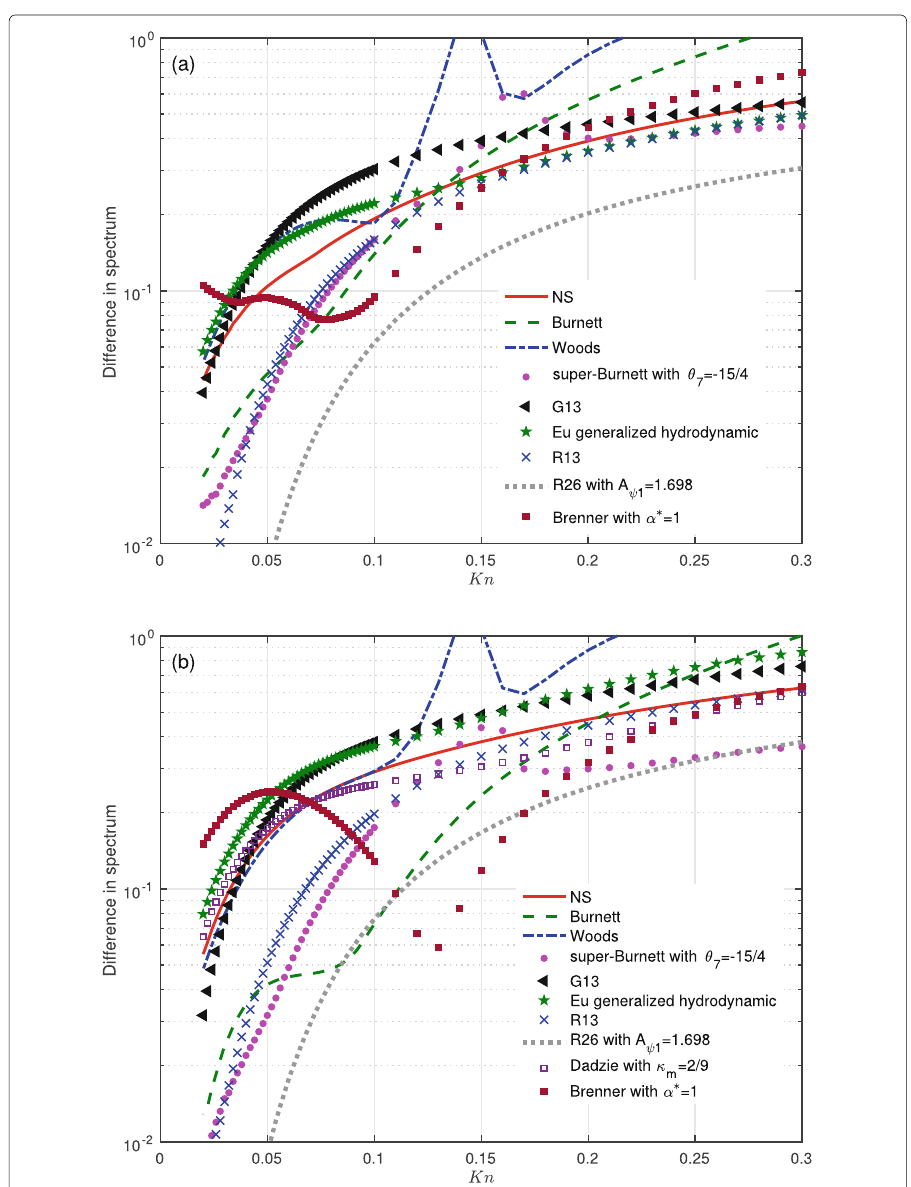
(cid:7) ∞ | S LBE − S Mac | df Fig. 9 Difference s in the spectrum of spontaneous ( a ) and coherent ( b ) RBS between ∞ solutions of LBE and macroscopic equations. Note that before the comparison, areas of RBS spectra are normalized to unity. The solution may be viewed to be accurate when the relative difference is less than 0.05. Note that super-Burnett with θ 7 = − 15 / 4, Brenner’s, and Dadzie’s equations are purely